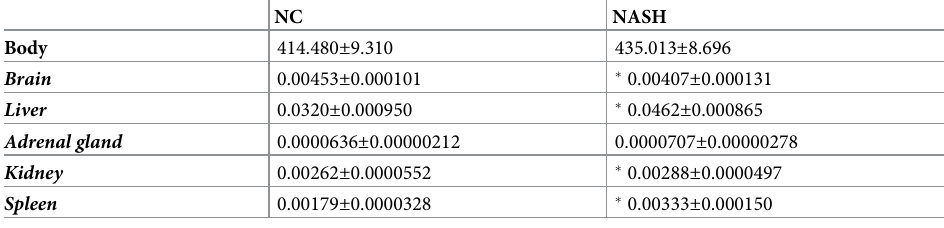
Table 1. Body weight (g) and organs’ relative weight (g/g)